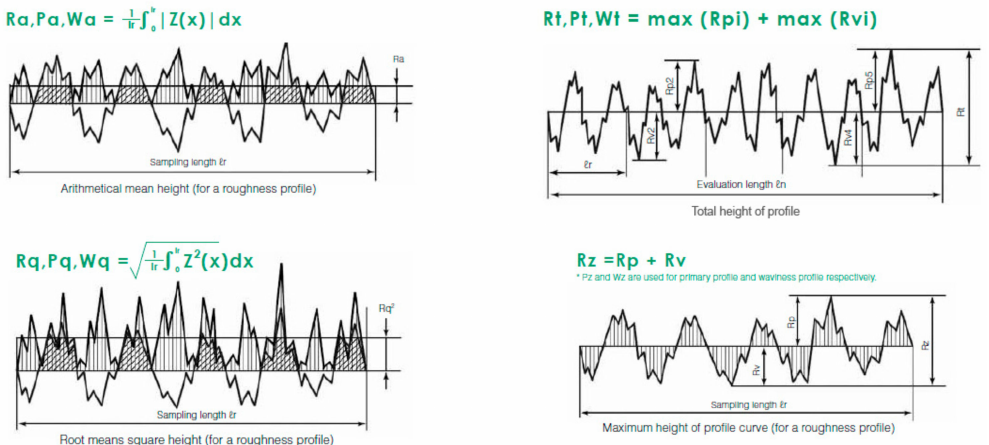
Figure 1. Graphics of the roughness parameters evaluated included R a , R q , R t , and R z